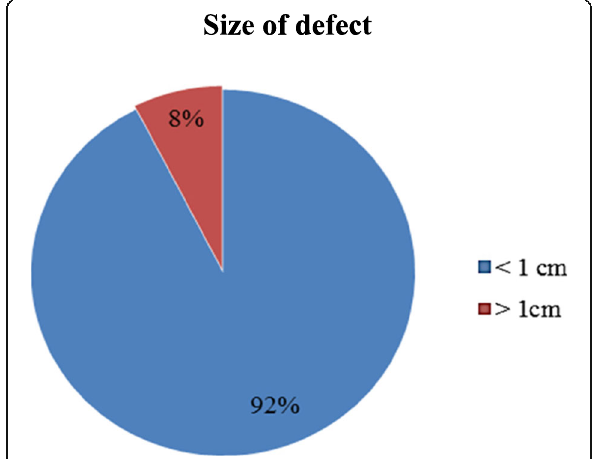
Fig. 1 Distribution of the studied group according to the size of defect